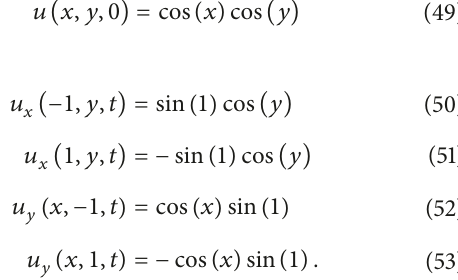
Figure 2: Plot of 𝑢(𝑥 = 0, 𝑡) for various values of 𝛼 .